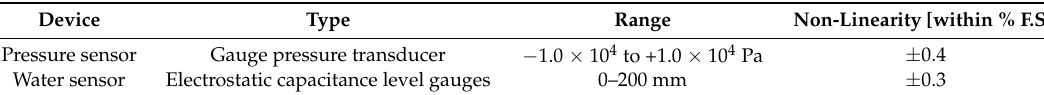
Table 2. Specifications of measurement devices.